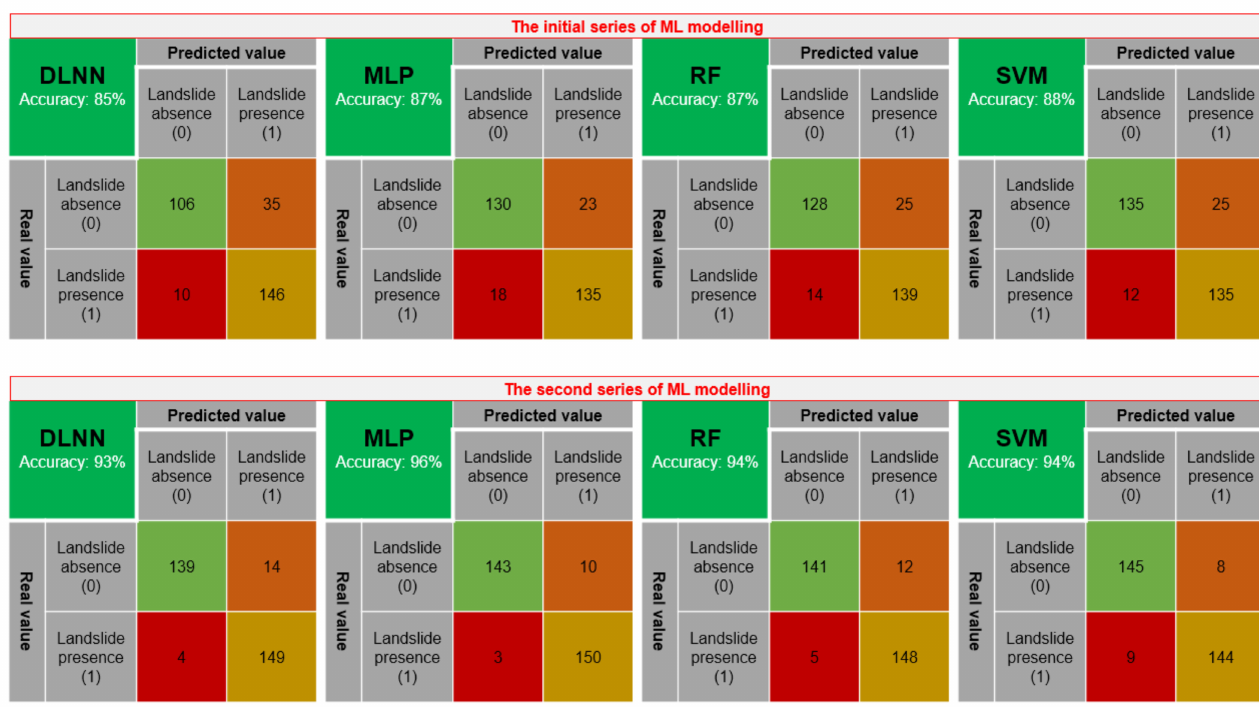
Figure 7. Confusion matrices showing the assessment results of binary classification capability of the four models involved in the initial (without considering discontinuities) and second (including discontinuities) series of ML